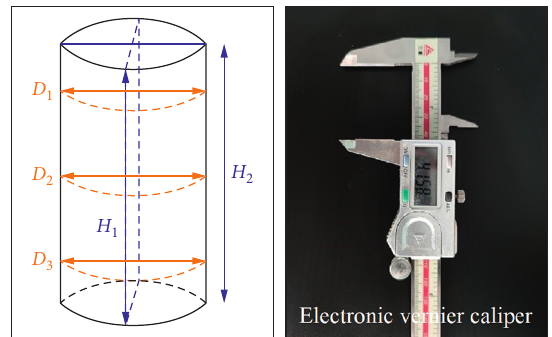
Figure 7: Schematic diagram of sample dimension measurement.